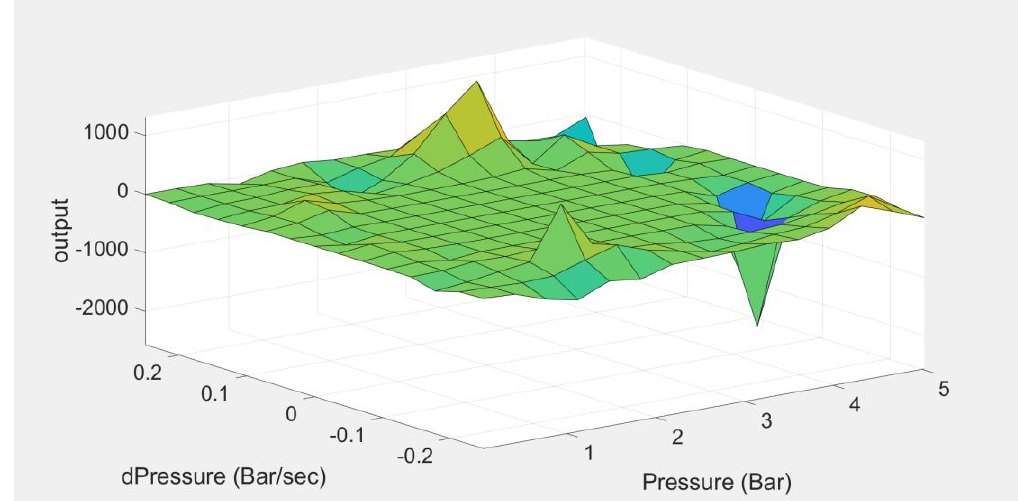
Figure 6. Rule base surfaces of the ANFIS hysteresis model.